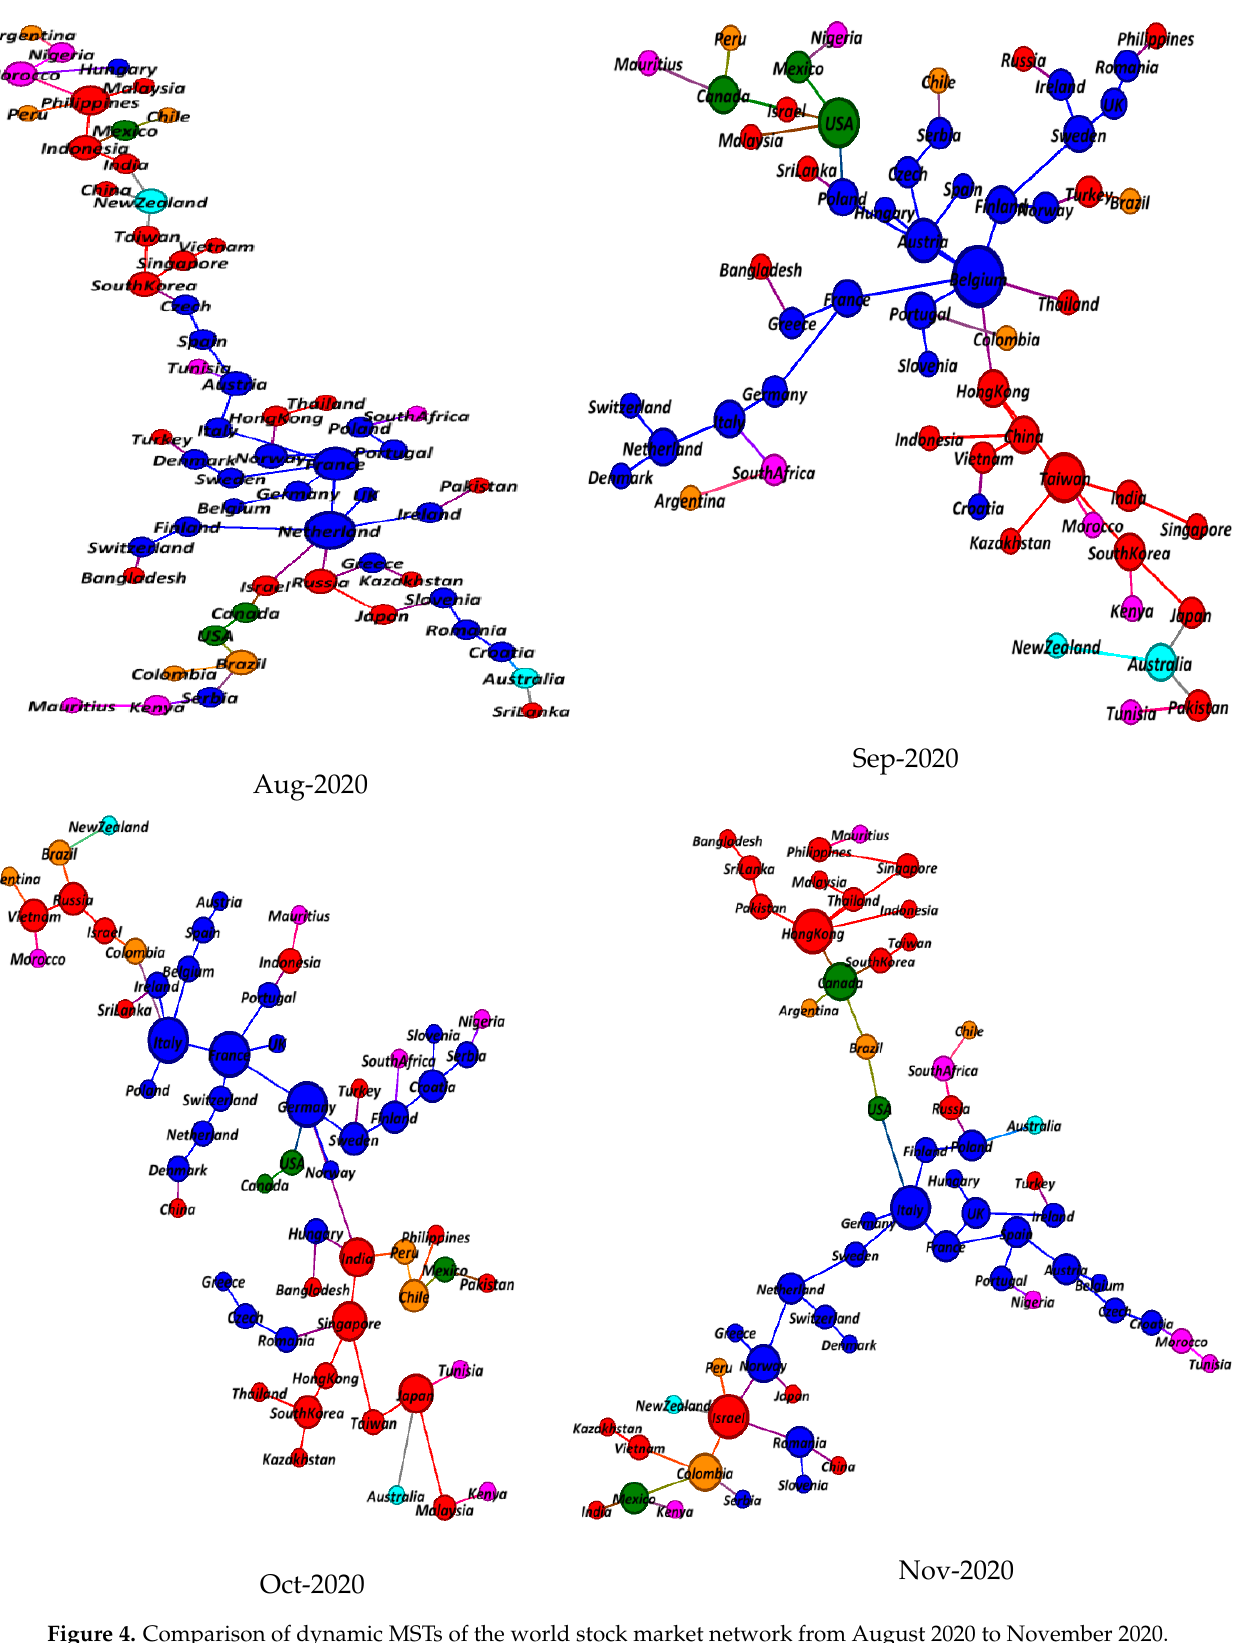
Figure 4. Comparison of dynamic MSTs of the world stock market network from August 2020 to November 2020.